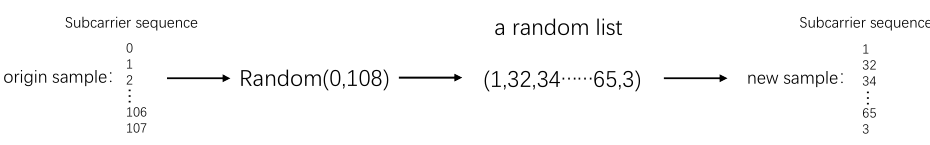
Figure 5. Data augmentation: Subcarrier rerank, Randomly adjust the order of subcarriers of OFDM